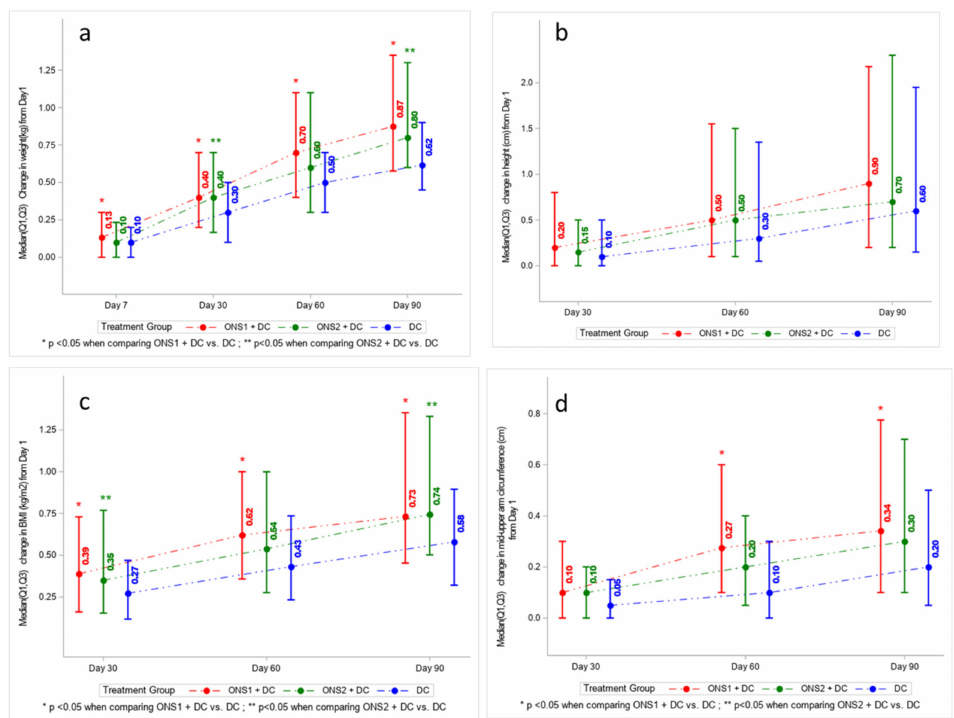
Figure 3. Change from Day 1 to Days 30, 60, 90 by study group for ( a ) weight, ( b ) height, ( c ) Body Mass Index, and ( d ) Mid Upper Arm Circumference.